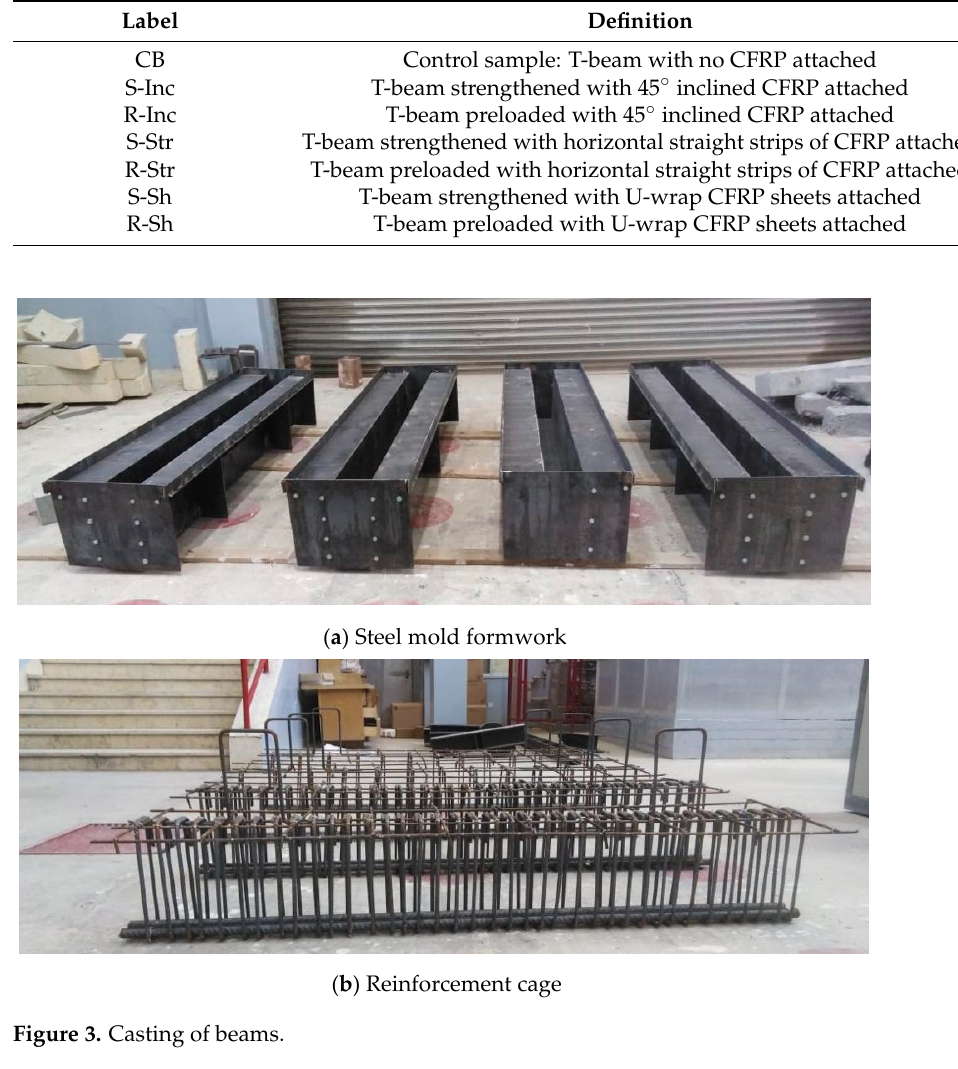
Table 7. Test specimen notations.